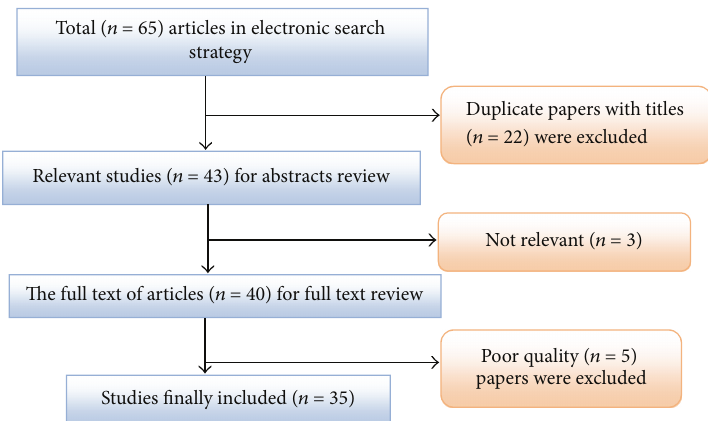
Figure 1: Results of the systematic literature